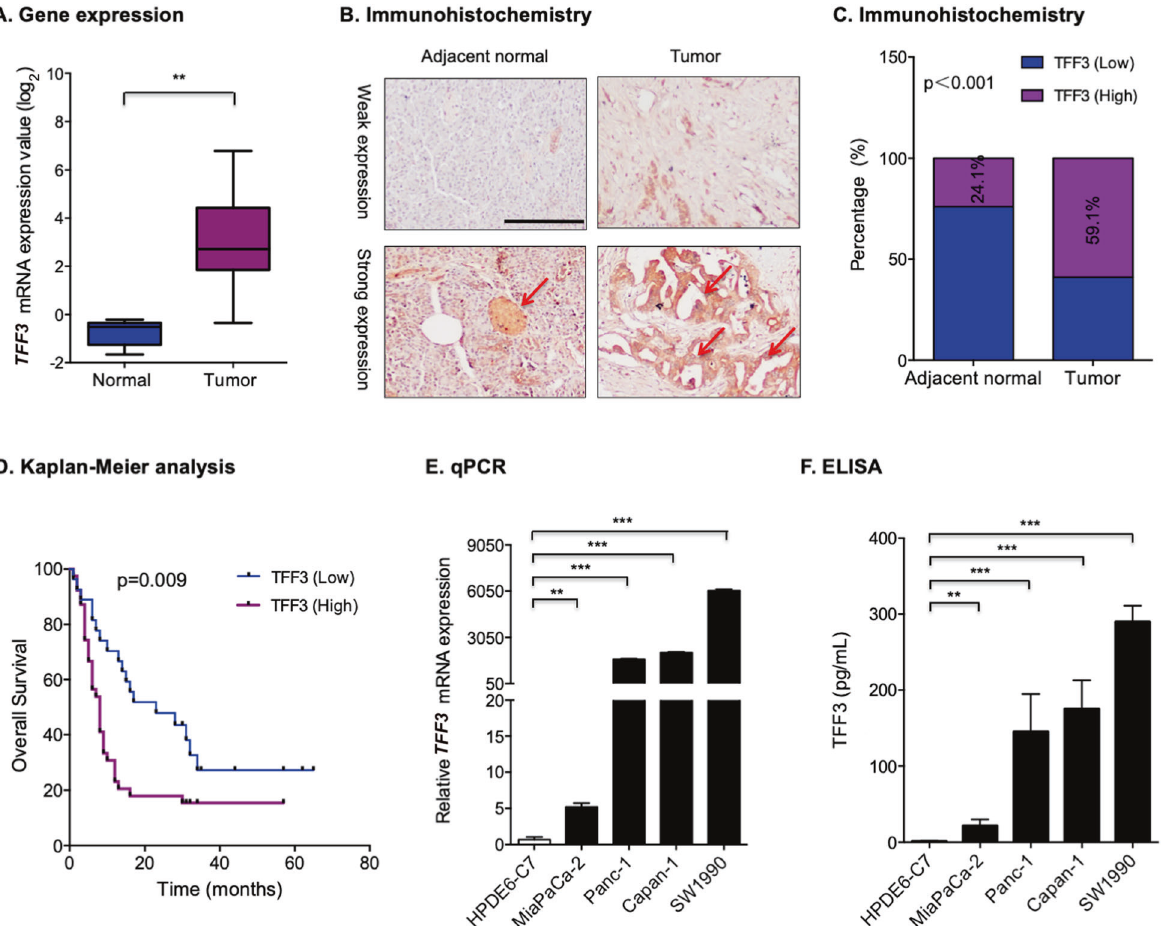
Fig. 1 TFF3 expression was increased in PDAC. A Transcriptomic analysis of TFF3 via a publicly available database (Oncomine). Data represent means ± SD. * P < 0.05, ** P < 0.01, and *** P < 0.001. B IHC analysis for TFF3 protein expression in PDAC and normal tissues. Representative IHC images of TFF3 expression in adjacent normal and tumor tissues are shown. Scale bar, 20 μ m. C The percentage of high versus low expression of TFF3 in the adjacent normal and tumor tissues. D Kaplan – Meier analysis of overall survival in PDAC strati fi